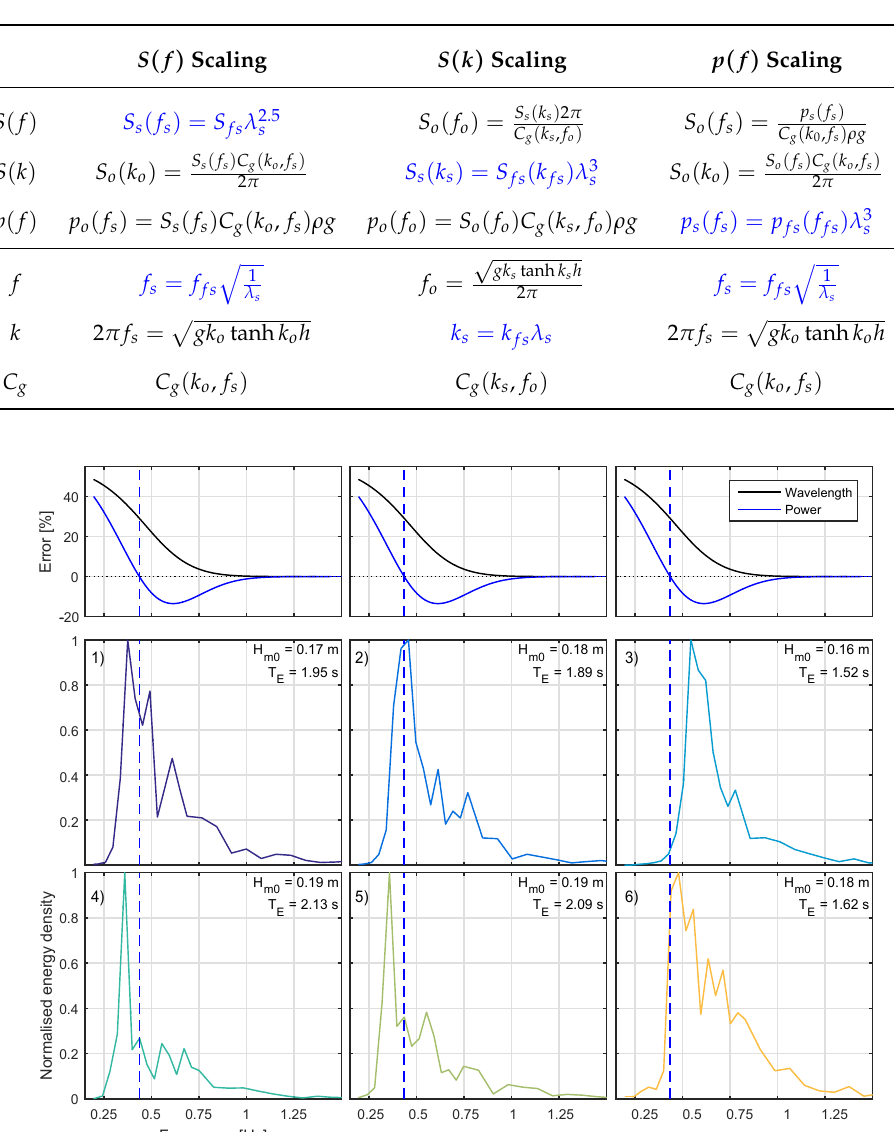
Figure 9. Extreme sea frequency spectra Froude scaled at 1:61. Resulting relative frequency dependent wavelength and power errors at this scale shown above. Dashed blue line indicated the frequency where power errors change sign (at this scale and depth ratio). 1 ) to 6 ) correspond to sea states 1 to 6 defined in Table